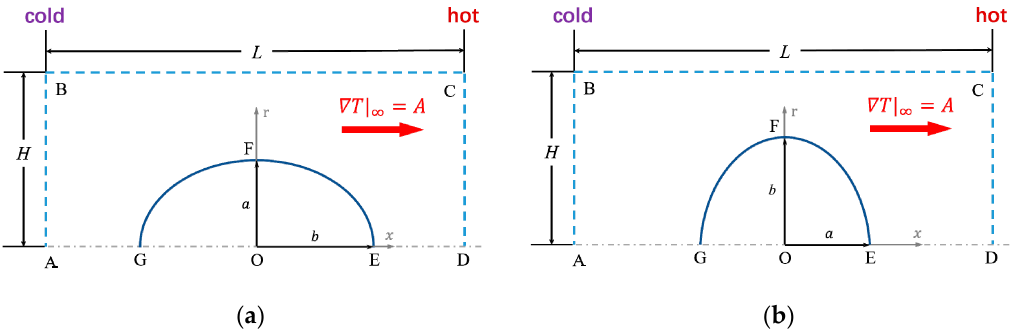
Figure 1. Thermophoresis of a charged spheroidal particle: ( a ) the prolate spheroidal particle with the major semiaxis b along the external applied temperature gradient A ; ( b ) the oblate spheroidal particle with the minor semiaxis a along the external applied temperature gradient A . With the center of the spheroidal particle located at the origin (O) of a rectangular domain ABCD with dimensions of L × H , the symmetric axis AD is along the external applied temperature gradient A . Boundaries AB and CD are set as the cold and hot sides, respectively, with the lengths of L and H being chosen as more than 200 times the minor semiaxis a , to avoid the boundaries’ effect on the thermophoresis. Boundary BC is the imagined boundary set in the far-field.